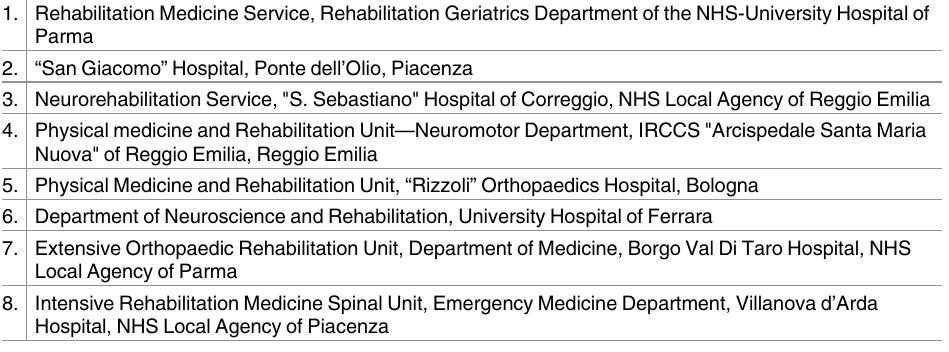
Table 1. Rehabilitation facilities participating in the